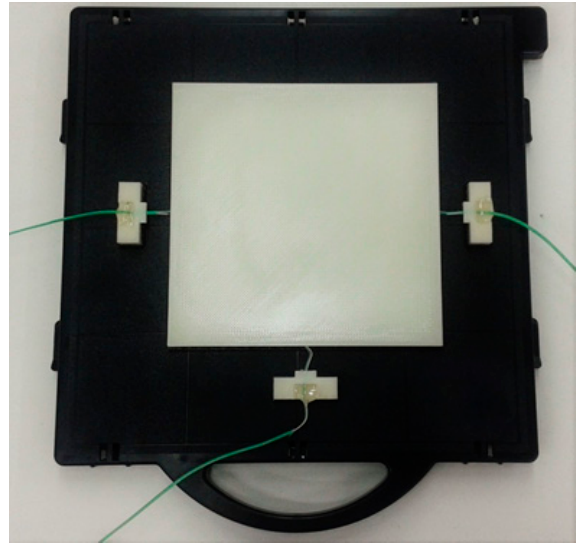
Figure 2. A representative plate specimen simultaneously built with its “alignment holders”.